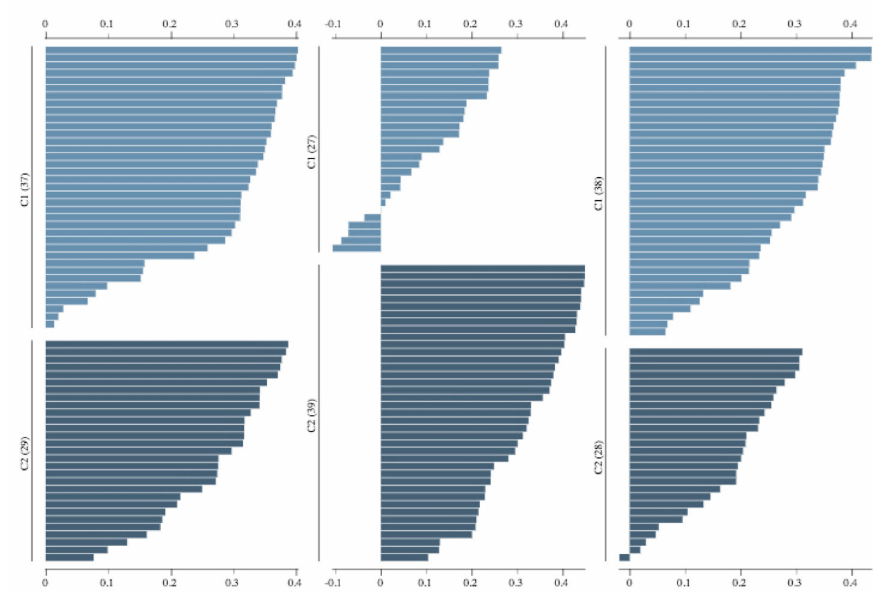
Figure 11. Sample allocation in found clusters C1 (light blue) and C2 (deep blue) per tissue type across silhouette scores (x-axis); the first plot is for kidney samples, the second for skin, and the third for colon